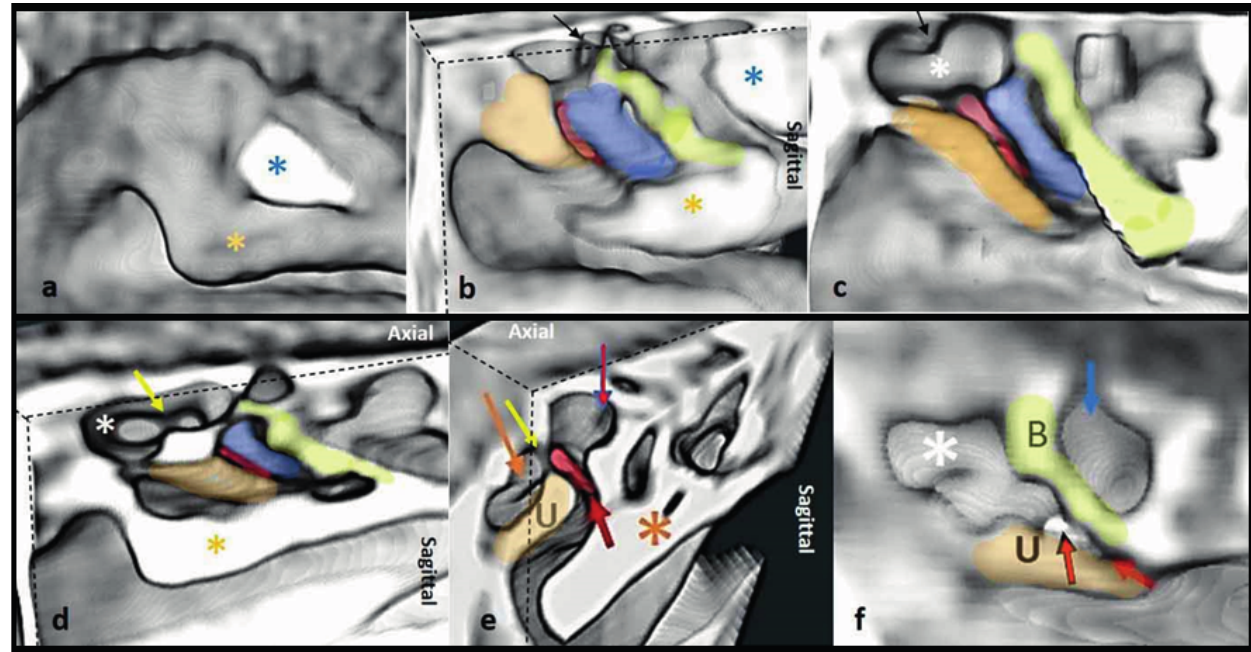
Figure 2. The creation of a single space above the AES folds in a 1month, 17-day old patient. a. Sagittal 3D image of the lateral nasal wall after virtual septoplasty. Middle Turbinate (gold asterisk), Superior Turbinate (blue asterisk). b.-f. Sagittal 3D images of the right nasal cavity and ethmoid sinus at various oblique angles. Note the “folds” of the UP (U, in gold), the Ethmoid Bulla (in blue) and the MT Basal Lamella (yellow-green). In figs (b., c.) the cartilaginous “ridge” (black arrow), which separates the spaces above the uncinate and ethmoid bulla, is undergoing dissolution as it is remodeled. Also note that the remodeled ridge has a dark contour. The dark density is also evi- dent in figs. (d., e.) at the yellow arrow, which marks the separation of the superior IS-EUP space (gold arrow) from the space above the EI (red outline, red arrow) and the EB (blue outlined red arrow). In figs. (c.-f.) the superior space above the uncinate and bulla folds is a united singular space (white asterisk). The Maxillary sinus opening (black outlined red